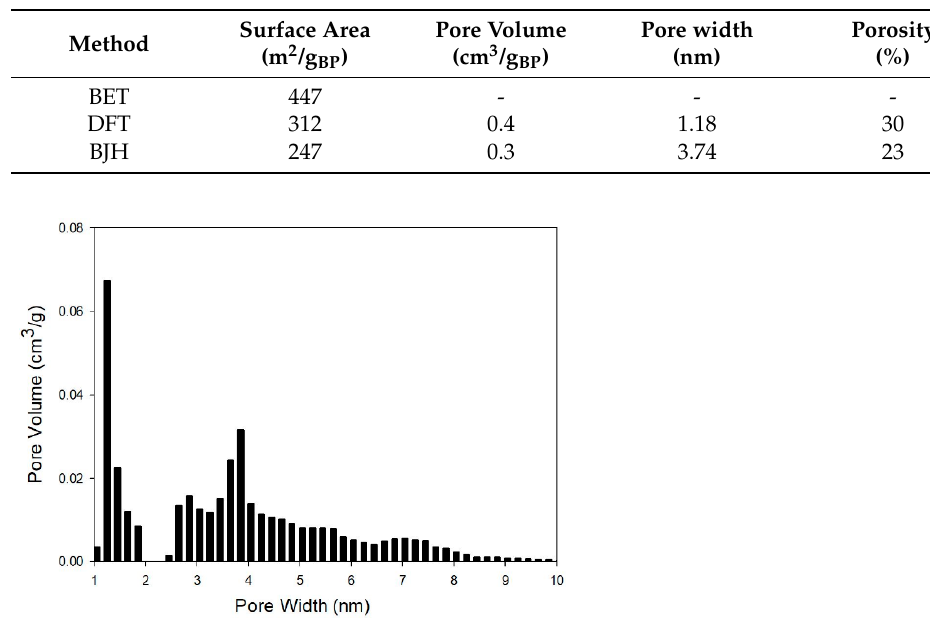
Figure 6. Distribution of the total pore volume by the total pore volume of all different pore widths